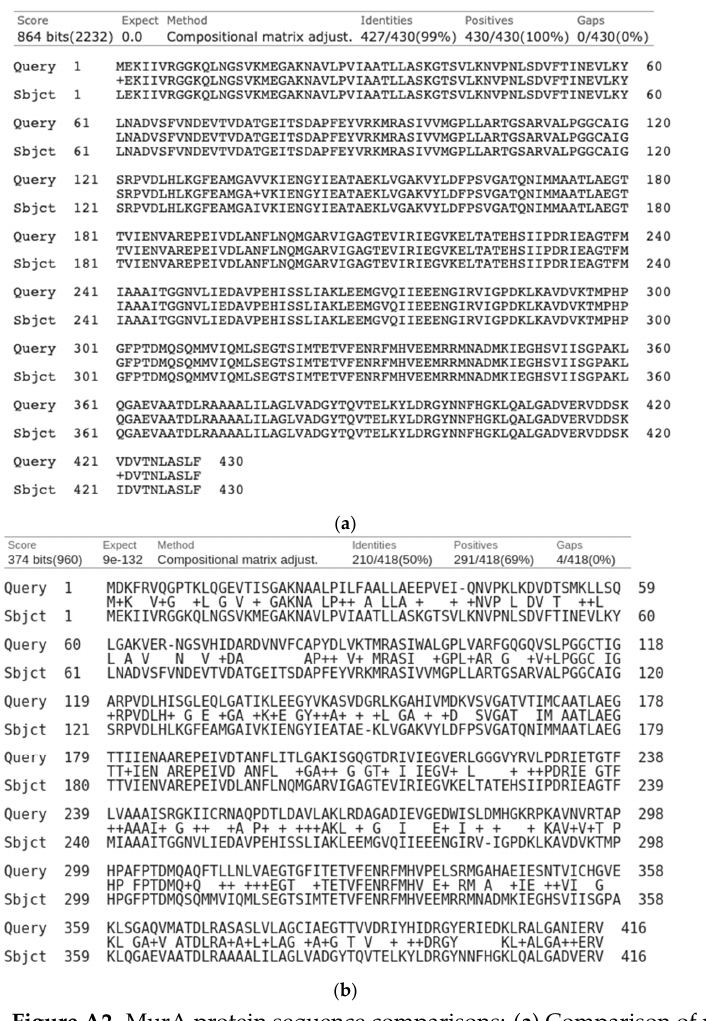
Figure A2. MurA protein sequence comparisons: ( a ) Comparison of protein sequence of MurA in Listeria monocytogenes (Q8Y4C4) and Listeria innocua (Q927W7) by using BlastP. Query = protein sequence of MurA in Listeria monocytogenes ; Sbjct = protein sequence of MurA in Listeria innocua . 99% sequence identity; ( b ) comparison of protein sequence of MurA in E coli (P0A749) and L. innocua (Q927W7) by using BlastP. Query = protein sequence of MurA in E coli ; Sbjct = protein sequence of MurA in Listeria innocua . 50% sequence identity.